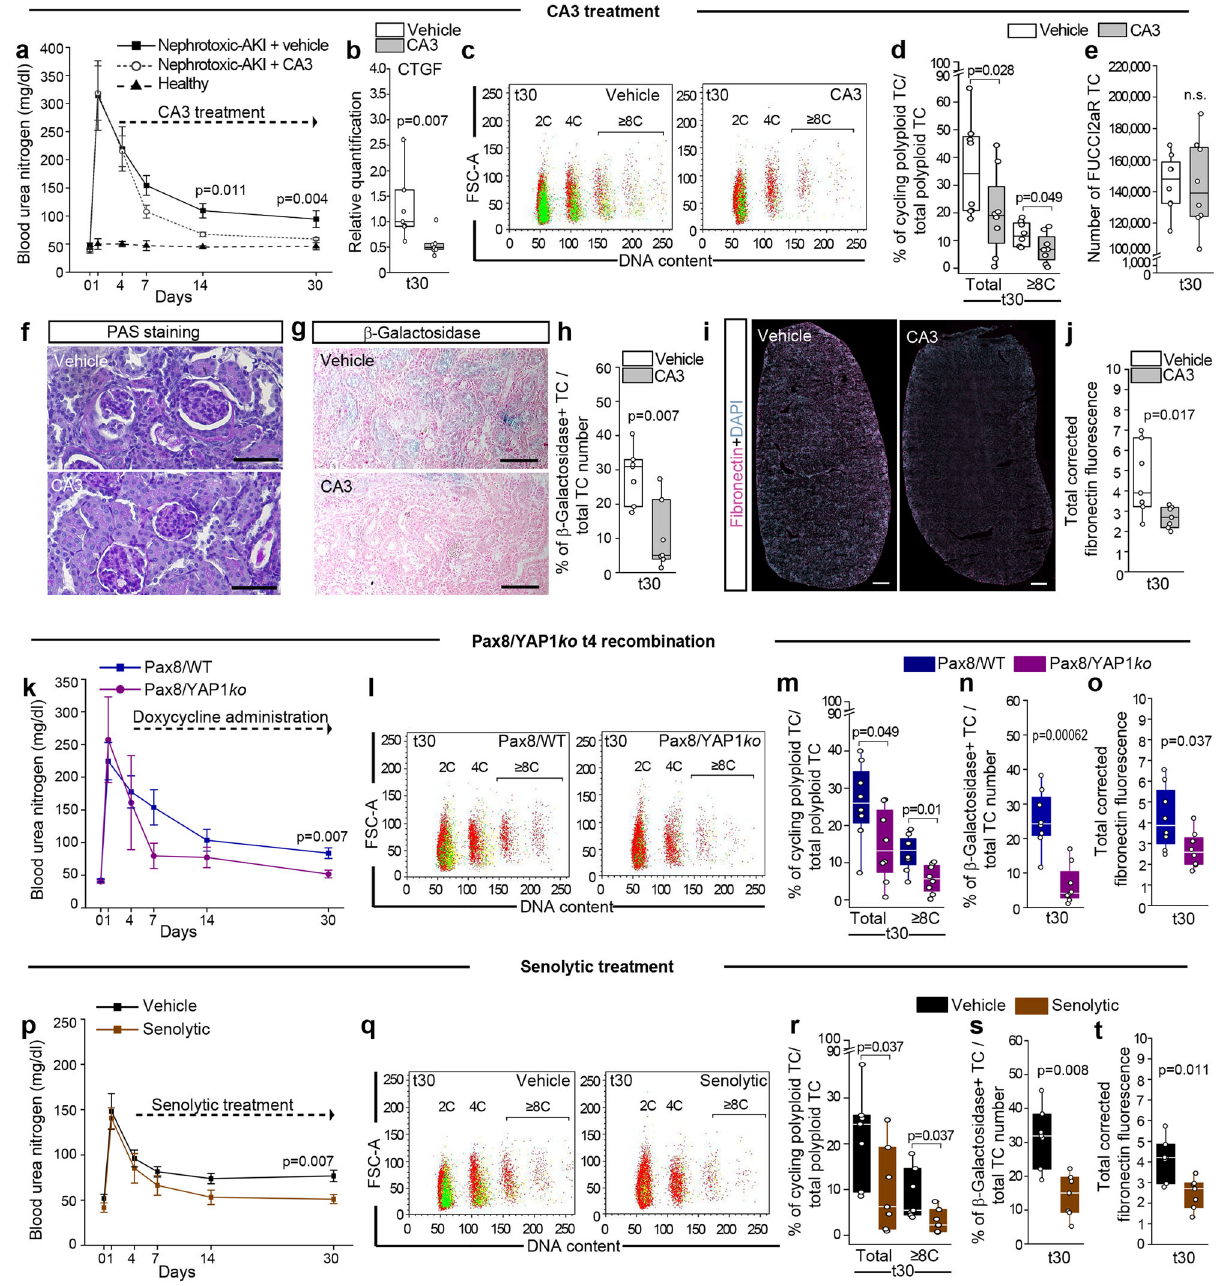
Fig. 9 | Time-dependent inhibition of tubular cells (TC) polyploidization attenuates AKI-CKD transition. a Blood urea nitrogen measurement in healthy WT mice ( n =5) and after nephrotoxic injury ( n =7). b qRT-PCR for YAP1-down- streamtargetCTGFinnephrotoxicinjuryafterCA3treatment( n =7). c FACSplots of TC in Pax8/FUCCI2aR mice after nephrotoxic injury, showing diploid (2C), tet- raploid (4C) and octaploid or greater ( ≥ 8C) TC ( n =8). Colours match the FUC- CI2aR reporter. d Percentage of total and ≥ 8C cycling polyploid TC in Pax8/ FUCCI2aR mice after nephrotoxic injury ( n =8). e Total number of FUCCI2aR TC after nephrotoxic injury ( n =8). f PAS staining in WT mice at day 30 after nephrotoxic injury ( n =7). Bars 50 µ m. g Senescence-associated β -galactosidase assay in WT mice at day 30 after nephrotoxic injury ( n =7). Bars 100 µ m. h Percentage of β -galactosidase + TC ( n =7). i Sequential scanning of kidney sec- tions stained for fi bronectin in WT mice at day 30 after nephrotoxic injury ( n =7). Bars 500 µ m. DAPI counterstains nuclei. j Quanti fi cation of fi bronectin deposition by digital morphometry ( n =7). k Blood urea nitrogen measurement in Pax8/WT and Pax8/YAP1 ko mice after nephrotoxic injury ( n =8). l FACS plots of TC after